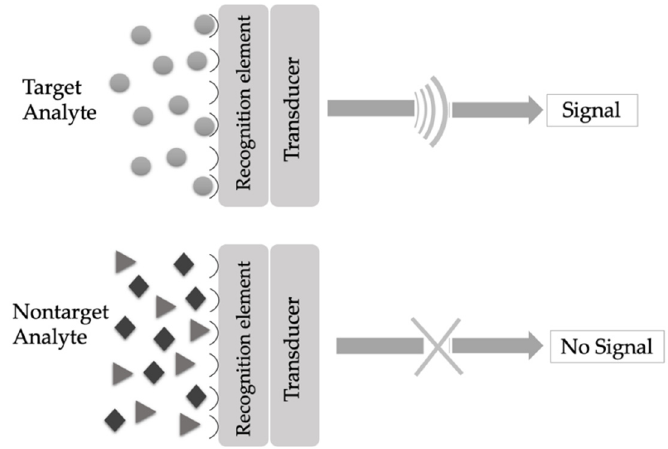
Figure 1. Working principle of a sensor.